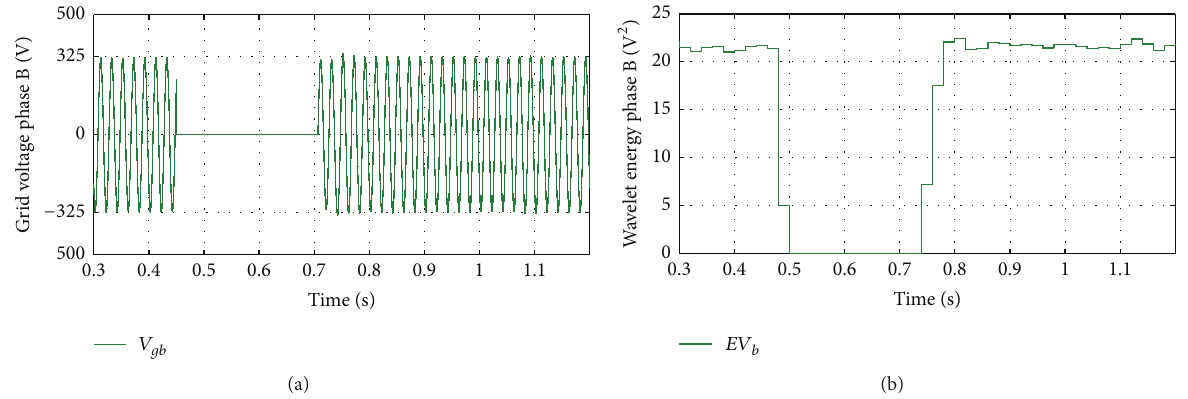
Figure 14: (a) Voltage signal and (b) corresponding wavelet energy plot for fault in phase B.